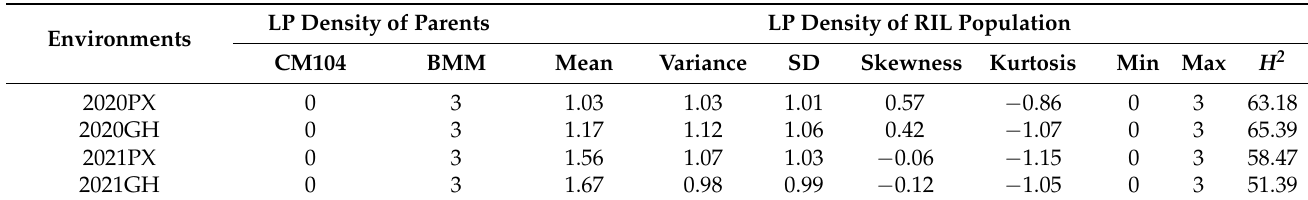
Table 1. LP density of the parents and recombinant inbred lines at the heading stage. Environments